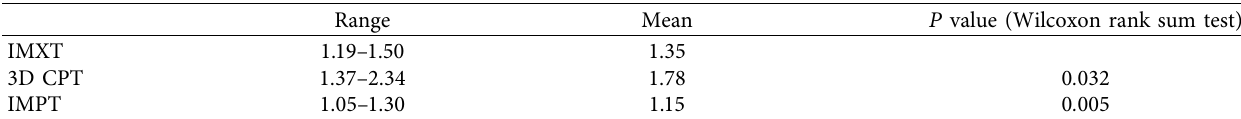
Table 3: PTV conformity